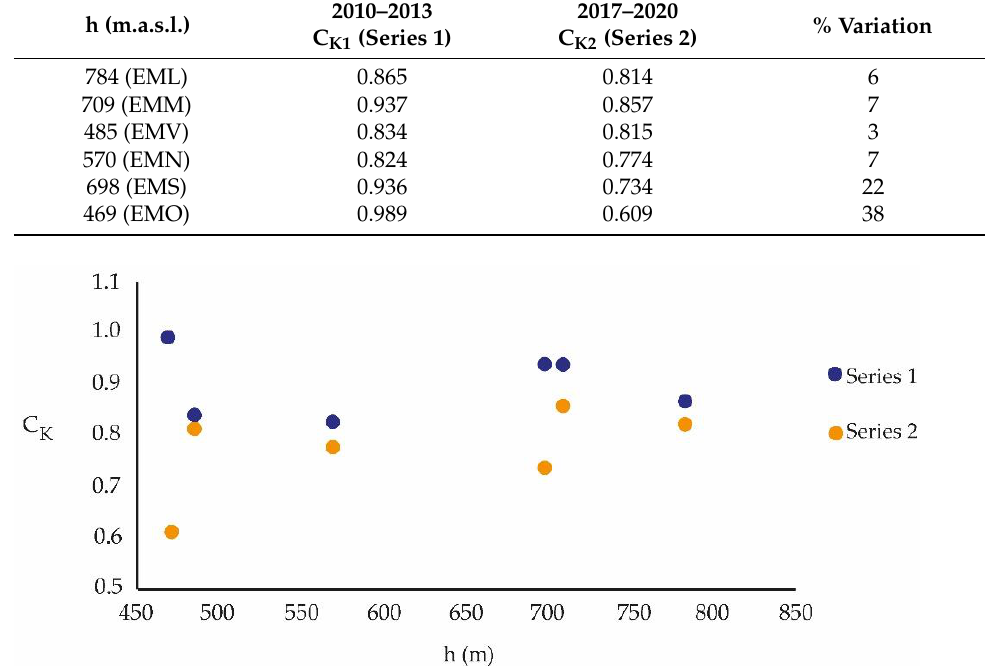
Table 3. Percentage variations of the C K . Figure 4. Distribution of entropies according to heights and periods of the pollutants.